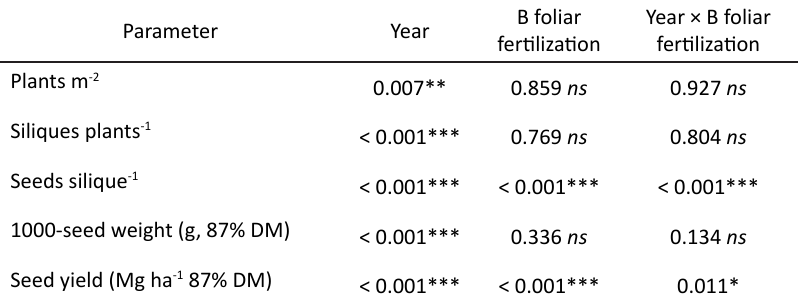
Table 2. P values ( p > F) in fixed effect tests for seed yield and yield components of winter